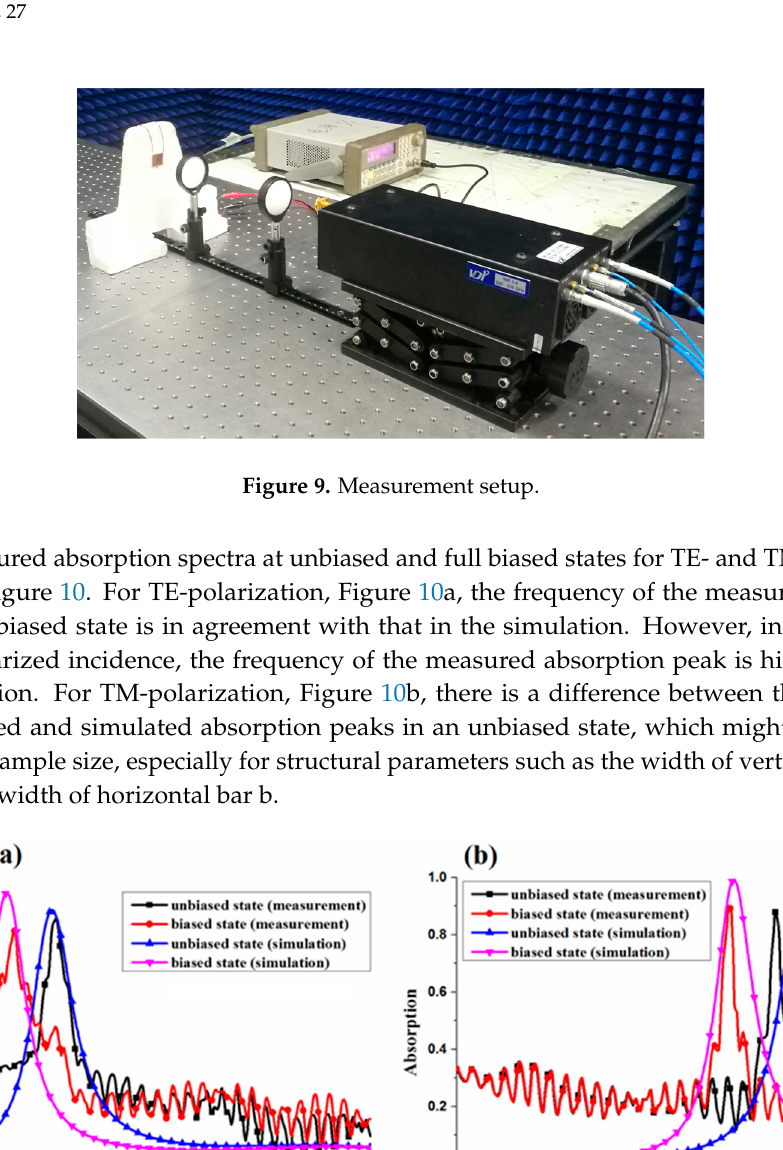
Figure 9. Measurement setup.